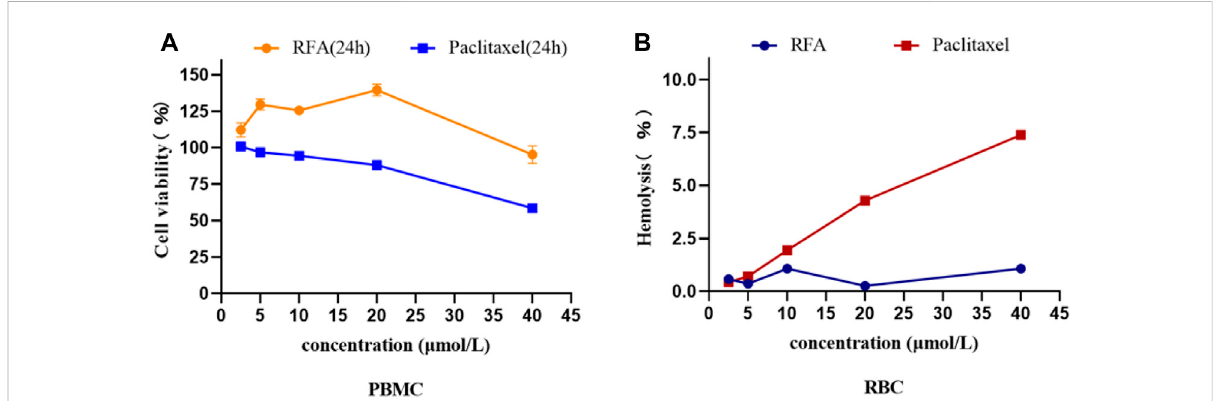
The effect of RFA on apoptosis of 786-O cells. (A) The morphology of apoptosis induced by RFA in 786-O cells was observed by fl uorescence microscopy(400×). (B) ThepercentageofapoptosisinducedbyRFAwasdetectedbyAnnexinV-FITC/PIdoublelabeling.Theapoptotic786-Ocells were in the FITC+/PI- and FITC+/PI + quadrant. Data were expressed as mean ± SD. t -test was used for the statistical analysis. * p < 0.05, ** p < 0.01, **** p < 0.0001, versus the untreated control